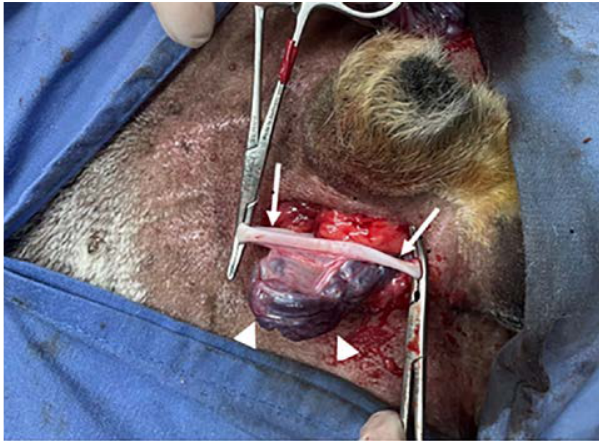
Figure 1: The ductus deferens (arrows) out of the spermatic cord; the ductus deferens is positioned medially of the pampiniform plexus (arrow heads)